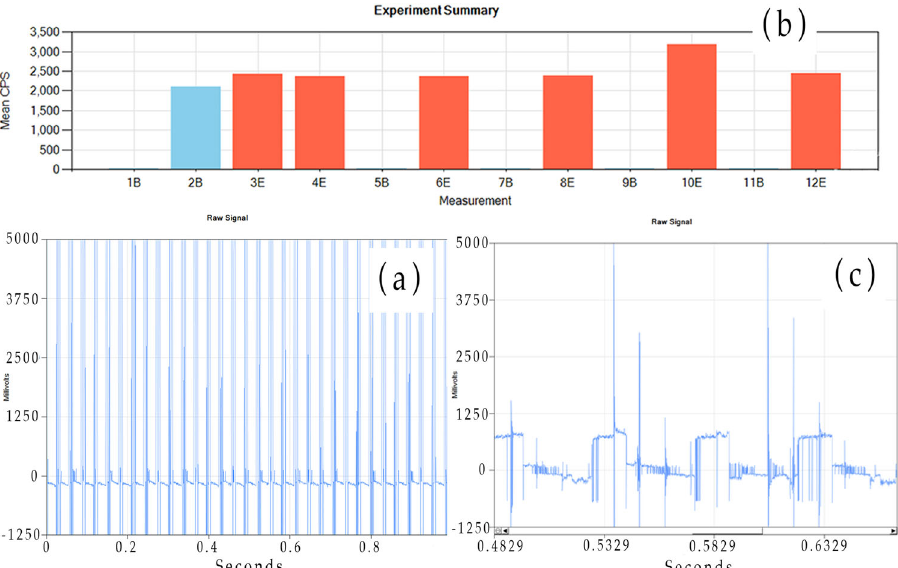
Fig. 3 Photonic energy values throughout the experiment. a The measured photon peaks over 5000 mV. Source data also shows photonic emissions in the negative regions (de-excited state) of the detector, which are consistent with elastic and inelastic Compound Nucleus renormalization 54 . b Summary values of the experiments in conjunction with radioactive 55 Fe and ambient background data points between run-time internals. c Photonic data zoomed in, which detects transient photonic residual ringing spikes. This calibrated photon data shows atomic absorption coef fi cient behavior during amalgamation as the data crosses the (0 v) plane reference during OFF 360 Hz gate pulses. Note: Spectrum values ( a – c ), are from the SW experiments using stainless steel